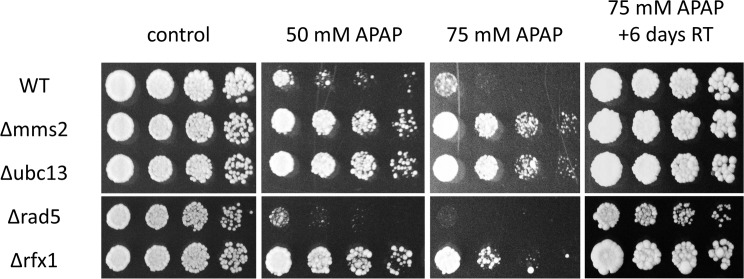
Deletion of DDR genes MMS2, UBC13, and RFX1 confers resistance to APAP.Fivefold serial dilutions of a cell suspension of the mutant strains with optical density OD600 = 0.05 were plated on YPD plates containing 0, 50 and 75 mM APAP and incubated for one (control) and three days at 37°C. After three days, the 75 mM plate was transferred to room temperature (RT) for 6 days. The strains used were WT (BY4741), Δmms2, Δubc13, Δrad5 and
Δrfx1.